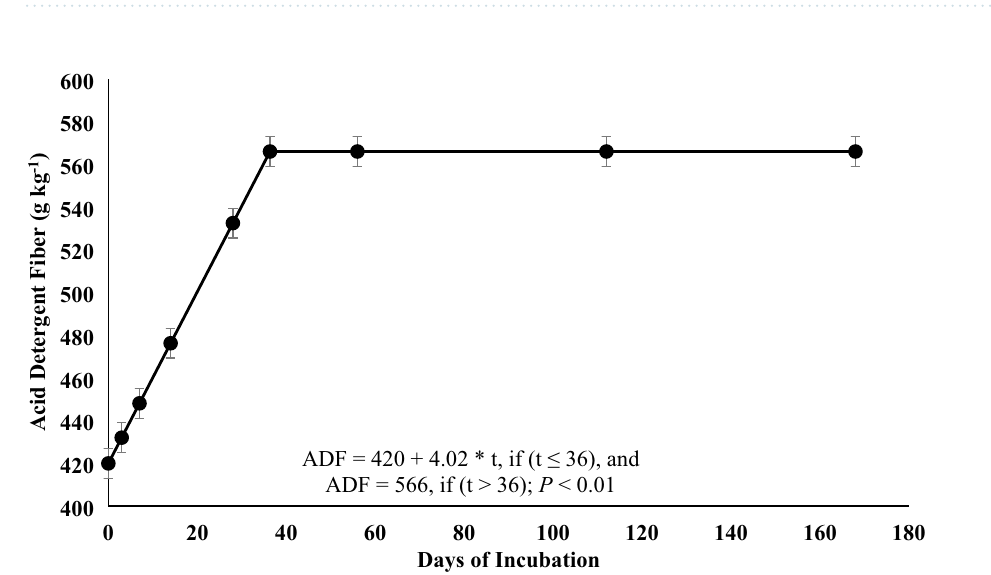
Figure 3. Acid detergent fiber of rhizoma peanut roots and rhizomes during a 168-days incubation period. The values represent the averages of two treatments (grazed and non-grazed) and 2 years. Bars refer to the